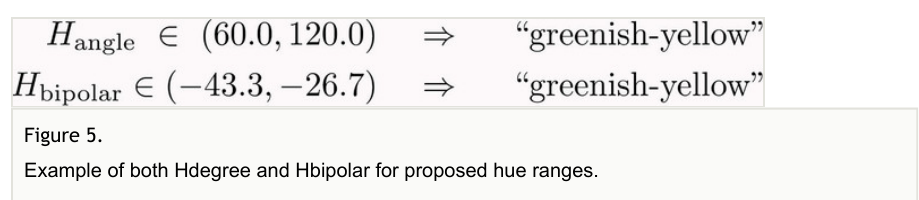
, H or using natural